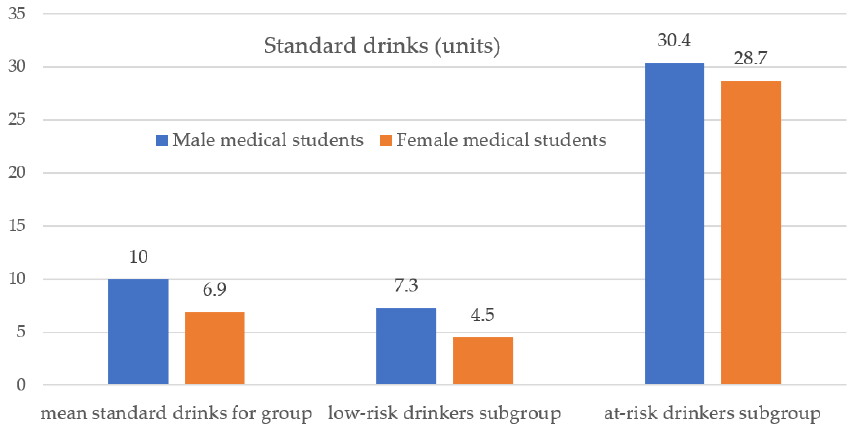
Figure 3. Mean units of drinks per week, by sex (for the entire group and the low-risk and at-risk consumption subgroups).